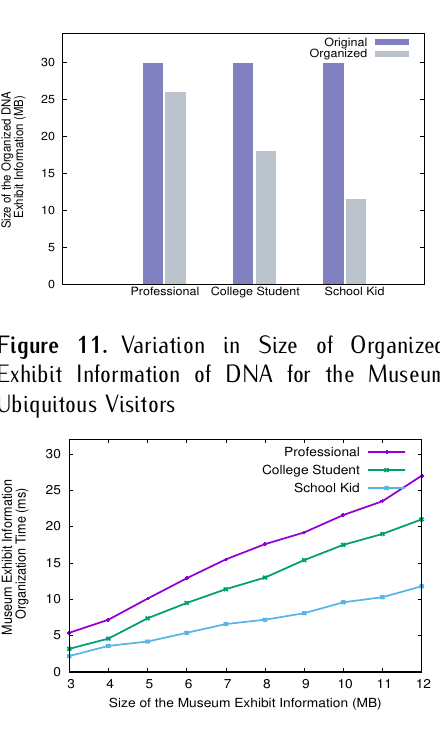
Figure 12. Museum Exhibit Information